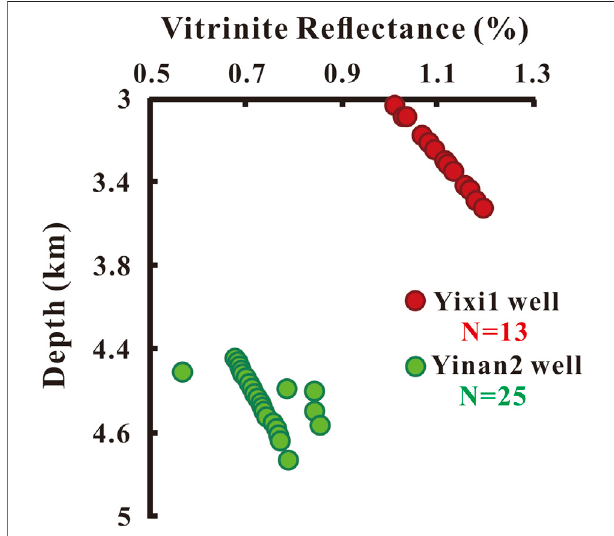
FIGURE6 | Variation of Ro with depth ofJurassic shale inwell Yixi1 and well Yinan 2 in the Kuqa Depression.